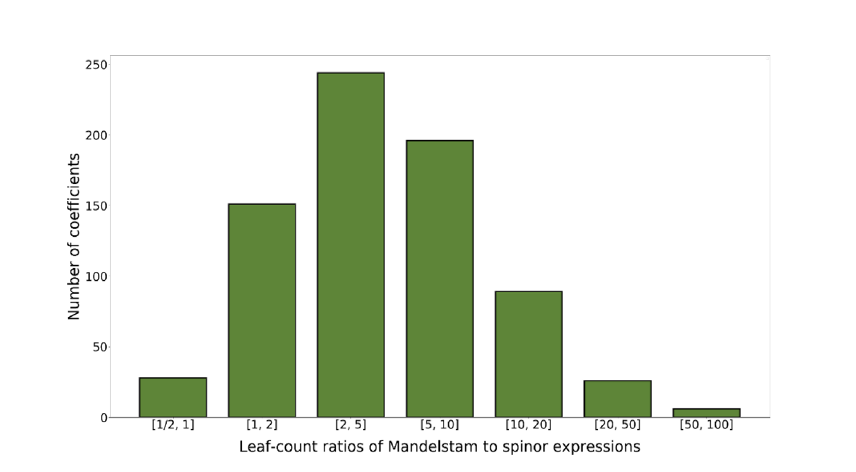
Figure 1 . Ratios of leaf counts of Mandelstam expressions to spinor-helicity